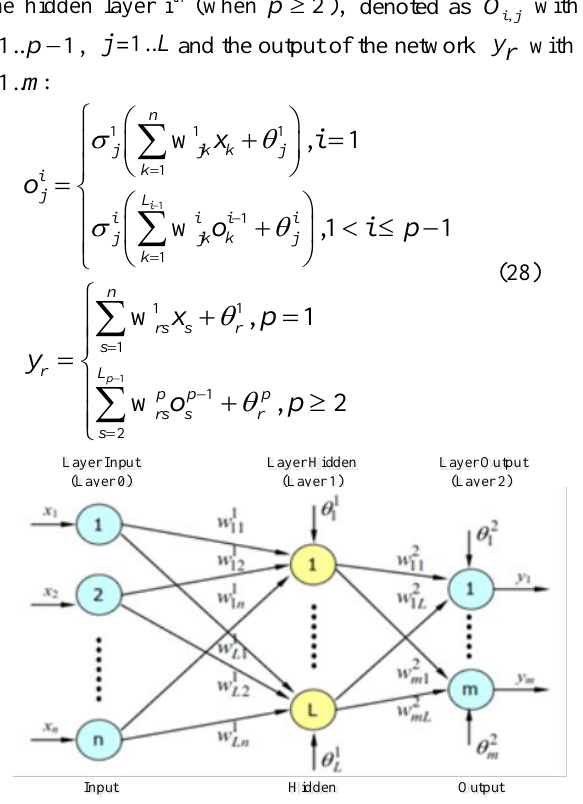
Figure 8. System 2-layer feed forward neural networks Figure 8 performances 2 layer feed forward neural networks (p = 2) has n input, m output linear and L buttons hidden. Network model is written as